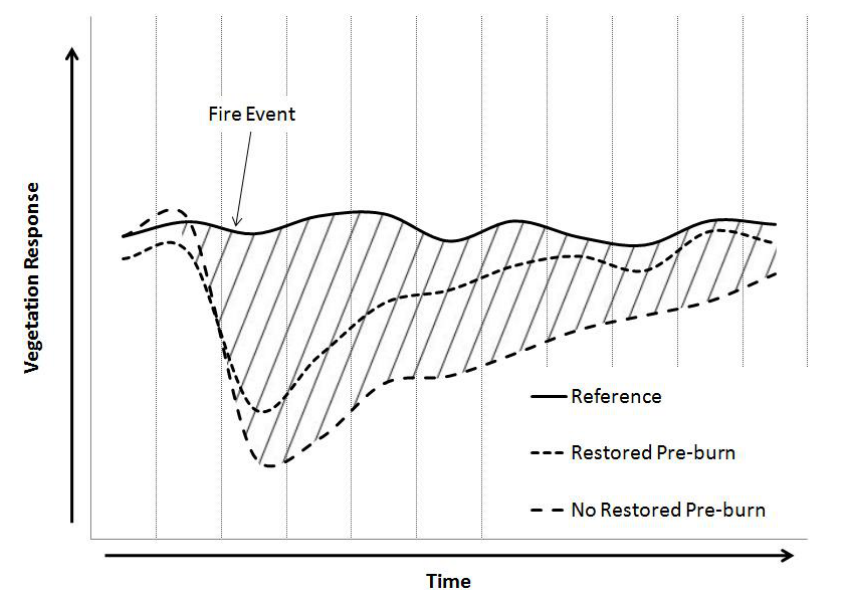
Figure 1. Conceptual representation of vegetation response (production proxy) to climate, restoration and wildfire disturbance. During wildfire events restored-burned areas are expected to have less damage due to a reduction in fire